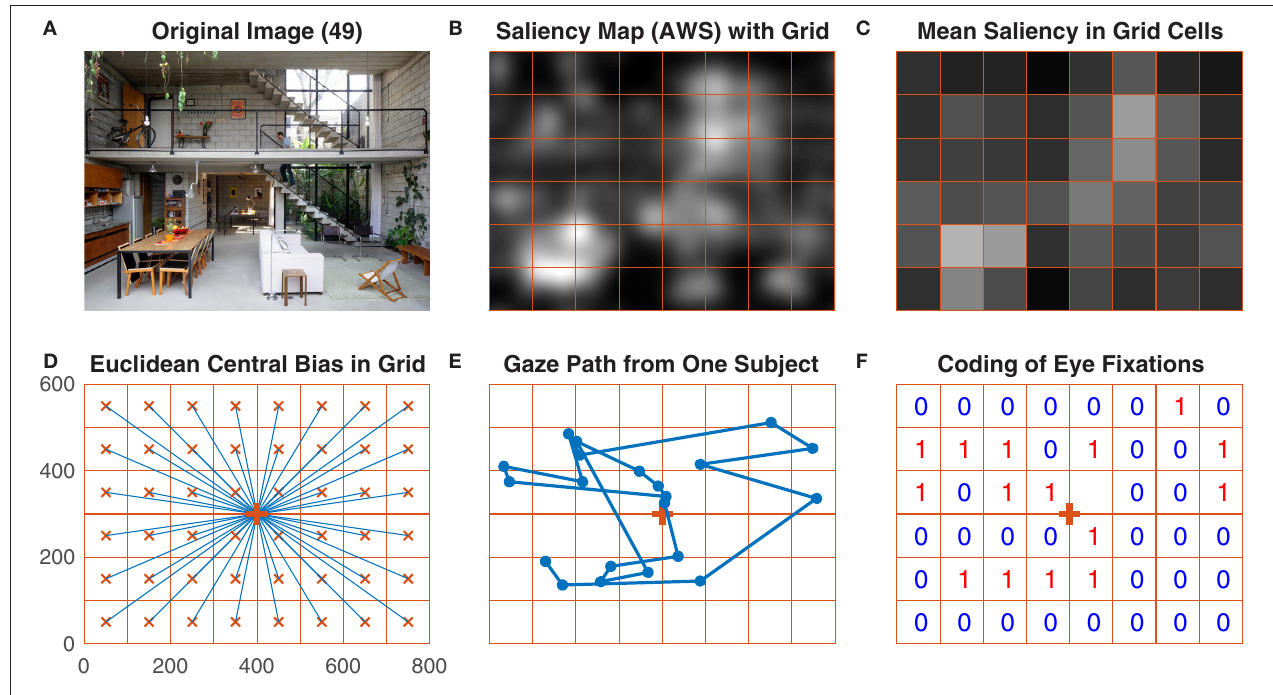
FIGURE 1 | Main steps of data processing performed by the GridFix toolbox. (A) One of the images used in the study. (B) A saliency map (Adaptive Whitening Saliency) for this image, with the analysis grid overlaid. Note that brighter areas indicate higher visual salience. (C) Mean saliency values for the grid cells, color-coded. (D) Image grid with vectors (in blue) connecting the center of the grid cell with the center of the image. (E) Gaze path from one subject over the image in (A). (F) Coding of this subject’s eye fixations in the image